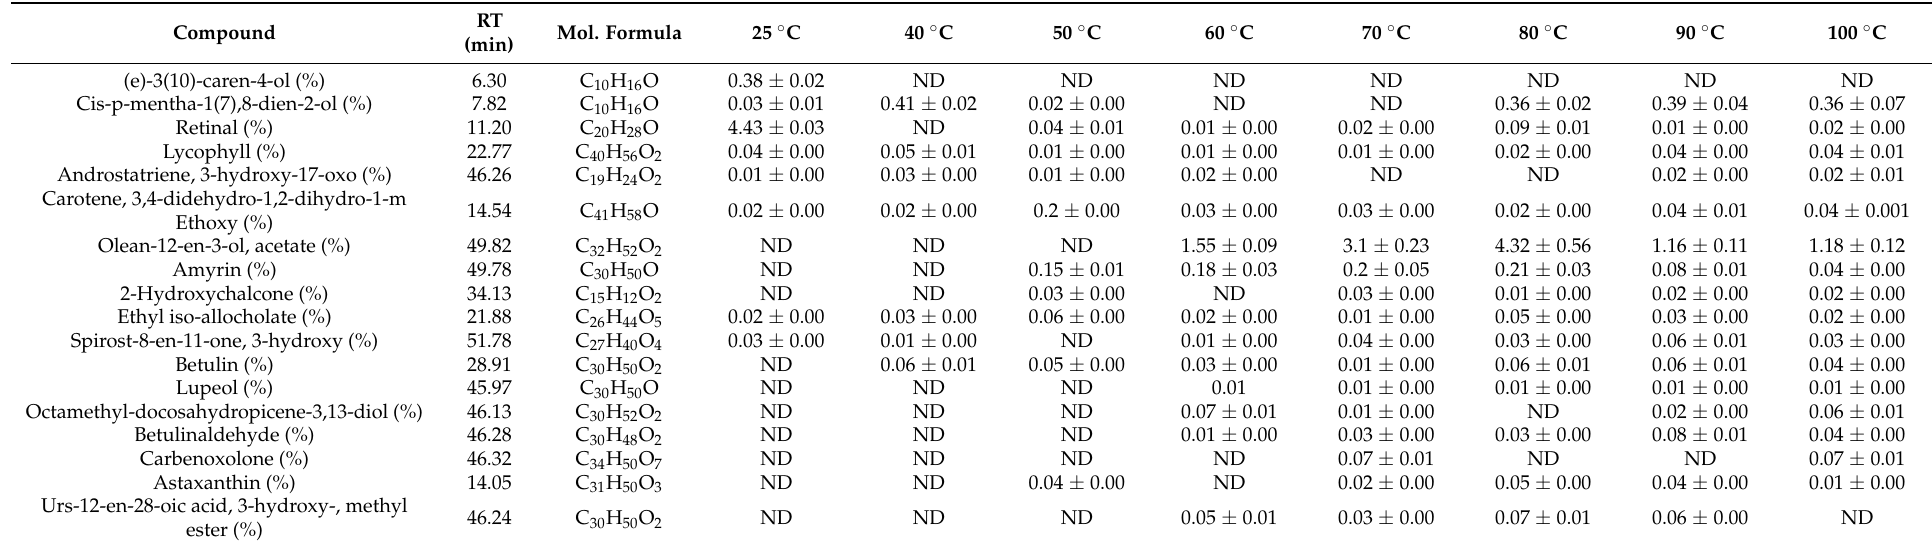
Table 3. Identification of lipidic compounds in oils at increasing